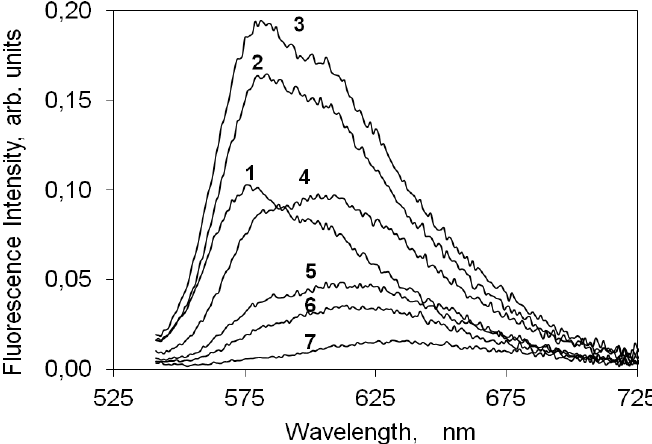
Figure 8. Steady-state emission spectra of the 3,3'-di(2-sulfoethyl)-indocarbocyanine dye onto β -cyclodextrin excited at 525 nm. The molar ratios are (0) 0 (1) 1:1000 (2) 1:500 (3) 1:250 (4) 1:100 (5) 1:50 (6) 1:25 (7) 1:10 of the cyanine dye to moles of β